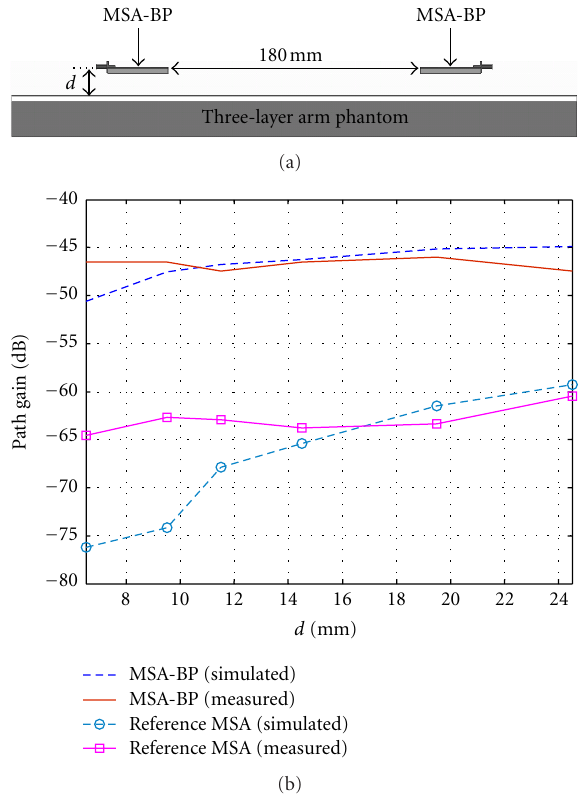
Figure 16: (a) Transmission scenario on the arm phantom, (b) Simulated and measured path gain with 2 MSA-BPs (resp. MSAs) 180mm apart on the